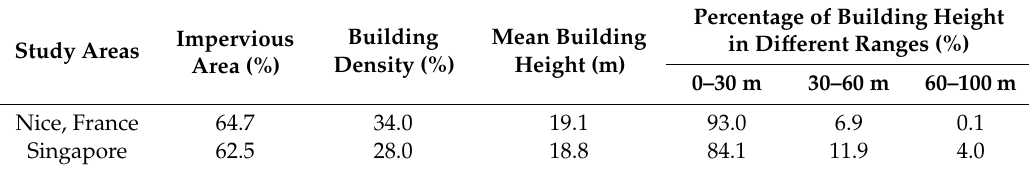
Table 4. The percentage of impervious area and building characteristics in study